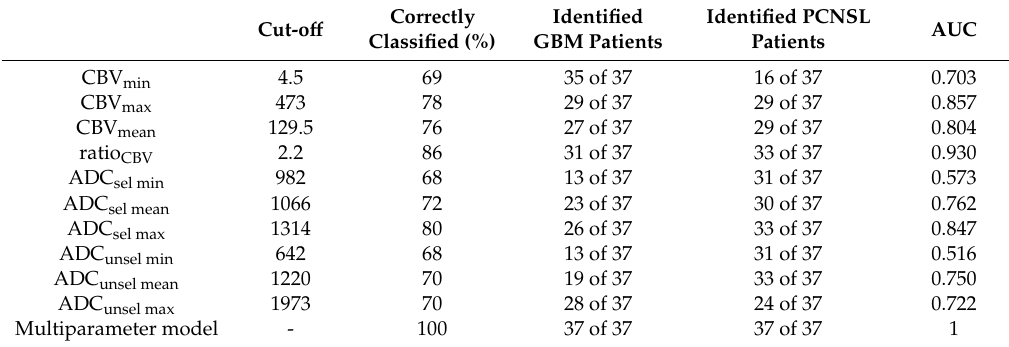
Table 2. Classification of GBM and PCNSL using single- and multiparameter models. Cut-o